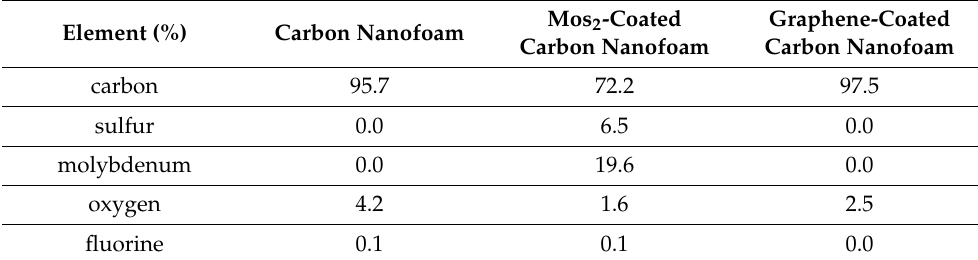
Table 1. Chemical composition of carbon